Question: Briefly state, in one sentence, what is plotted here.
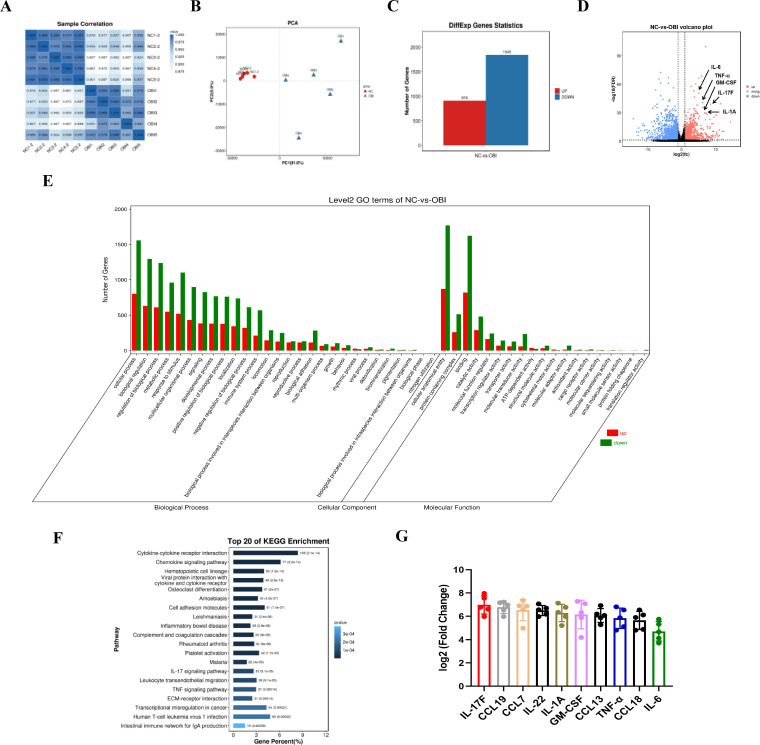
Answer: The transcriptome sequencing results of blood donors. ( A ) The Pearson correlation between samples using expression levels in the form of a heatmap. ( B ) The PCA result of respective clustered distributions for two groups. ( C ) DEGs analysis for two groups. ( D ) The fold changes of DEGs between two groups. ( E ) The GO function analysis of DEGs. ( F ) The KEGG pathway analysis of DEGs. ( G ) The top 10 upregulated DEGs related to fibrosis in the OBI group compared with healthy controls.